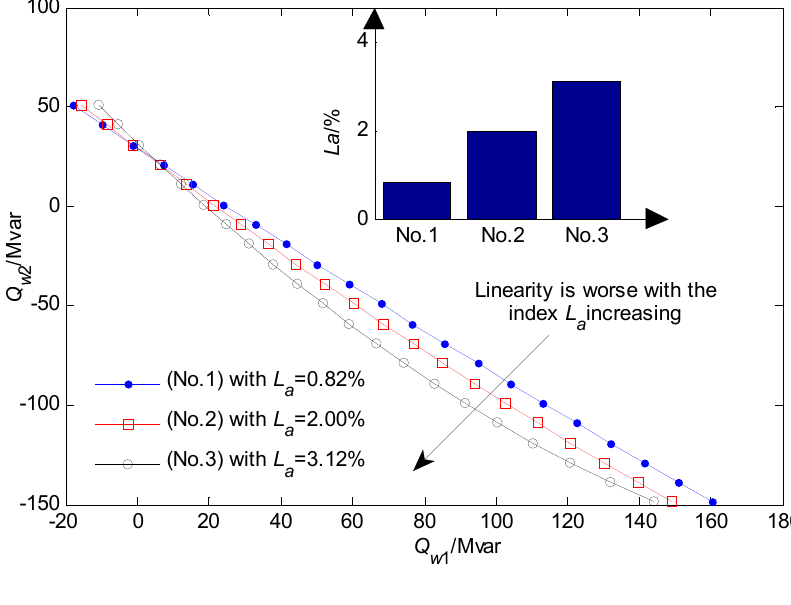
for different values of the line S